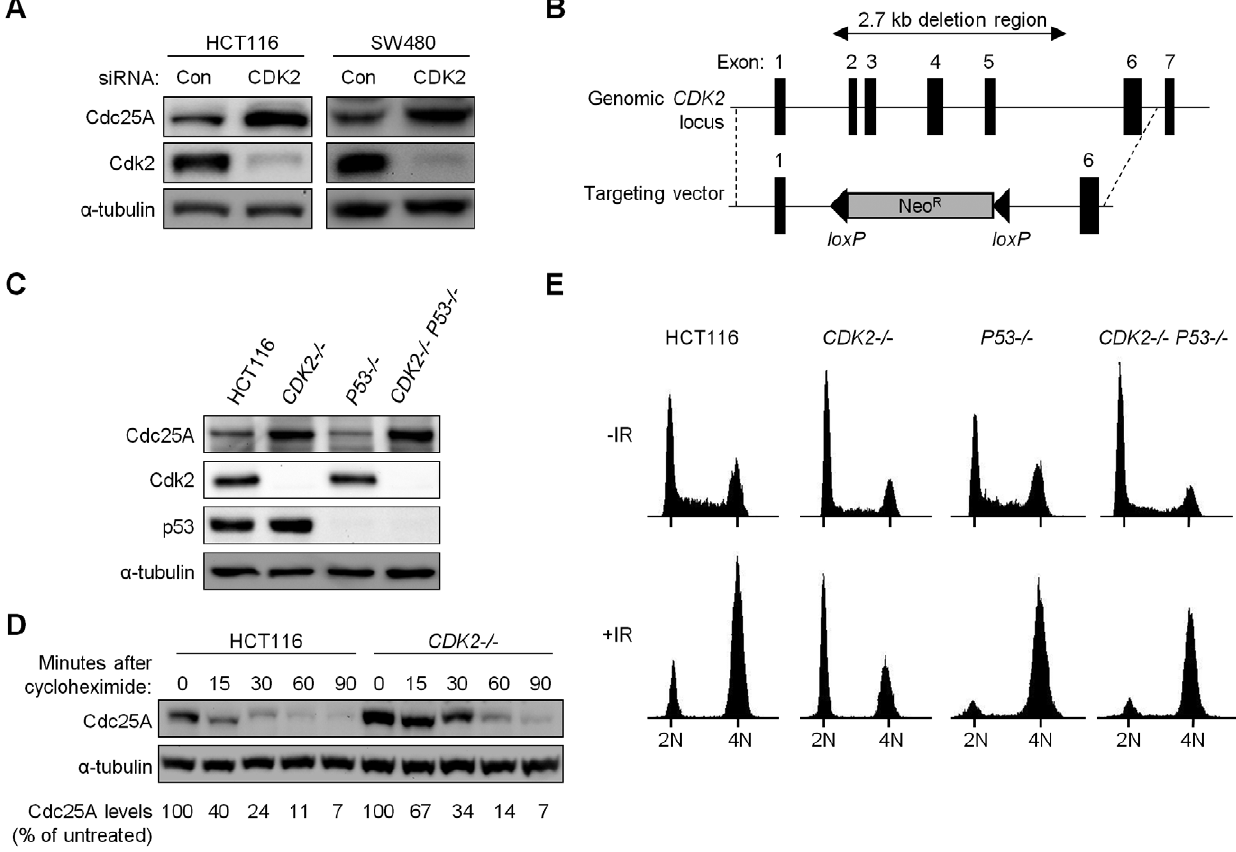
Figure 1. Altered cell cycle regulation and increased Cdc25A protein in Cdk2-deficient human cancer cells. (A) Human colorectal cancer cells HCT116 and SW480 transfected with control (Con) or CDK2 (CDK2) siRNA. Levels of Cdc25A and Cdk2 were analyzed by immunoblot. a -tubulin was assessed as a loading control. (B) CDK2 targeting strategy. Exons 2-5 at the CDK2 locus were replaced upon integration of the knockout vector. (C) Levels of Cdc25A, Cdk2 and p53 were determined by immunoblot in parental cells and single and double knockout cells. (D) Isogenic HCT116 cells were harvested at the indicated times after cycloheximide treatment. Cdc25A protein levels were analyzed by immunoblot, quantitated, normalized to a -tubulin and represented as a percentage relative to untreated control cells. (E) Isogenic HCT116 cells were fixed and stained with Hoechst 33258 and subjected to flow cytometry, before and 24 h after treatment with 12 Gy IR. Positions of cell populations with 2N and 4N DNA content are